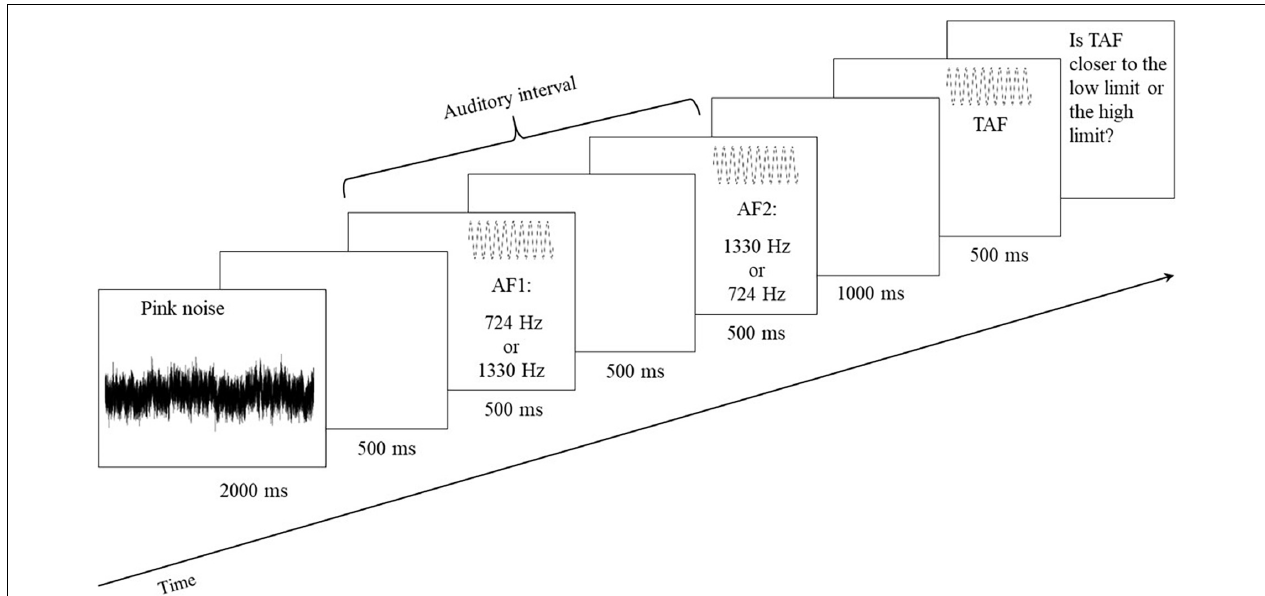
FIGURE 4 | Event sequence for each trial of the auditory interval bisection judgment. One trial began with pink noise for 2,000 ms, followed by the presentation of auditory limits (i.e., AF1 and AF2; 500 ms), each separated by a silence of 500 ms. After the auditory interval, there was a silent period of 1,000 ms followed by the TAF (500